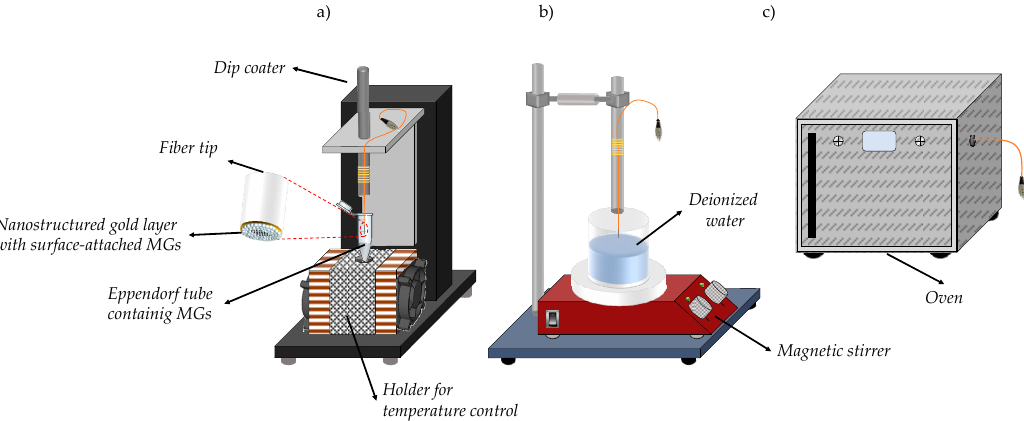
Figure 1. Schematic view of the dip coating procedure. ( a ) Dipping, ( b ) rinsing and ( c ) drying steps. The inset in ( a ) shows a schematic of the LOF probe integrated with MGs.